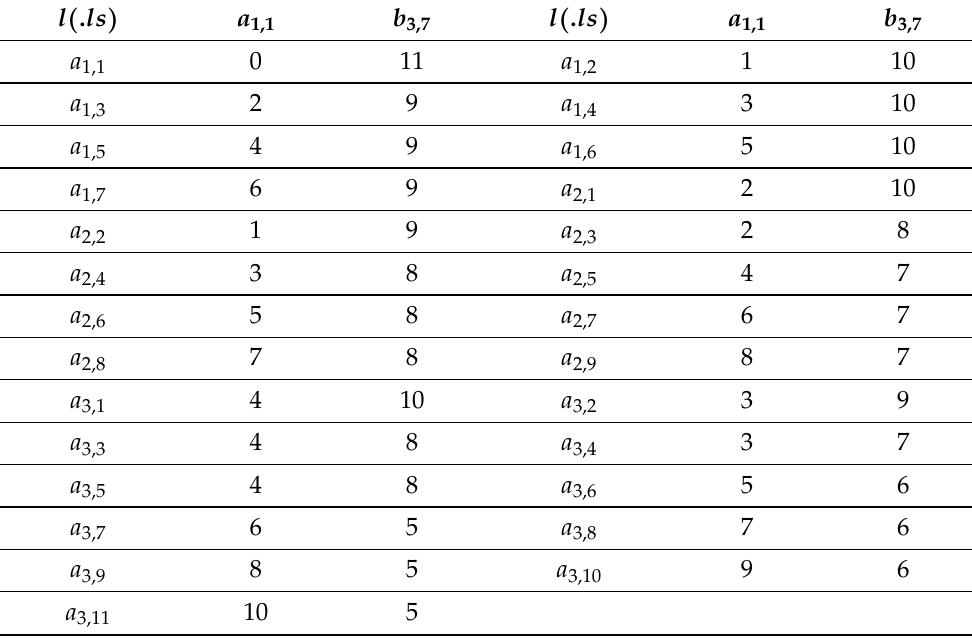
Table 5. Locations of the nodes of GHCN ( 3,3,3 ) .